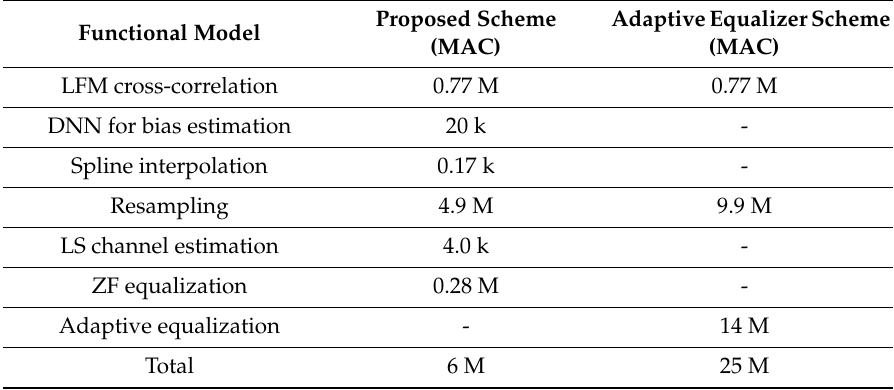
Table 2. Complexities of the receivers for one